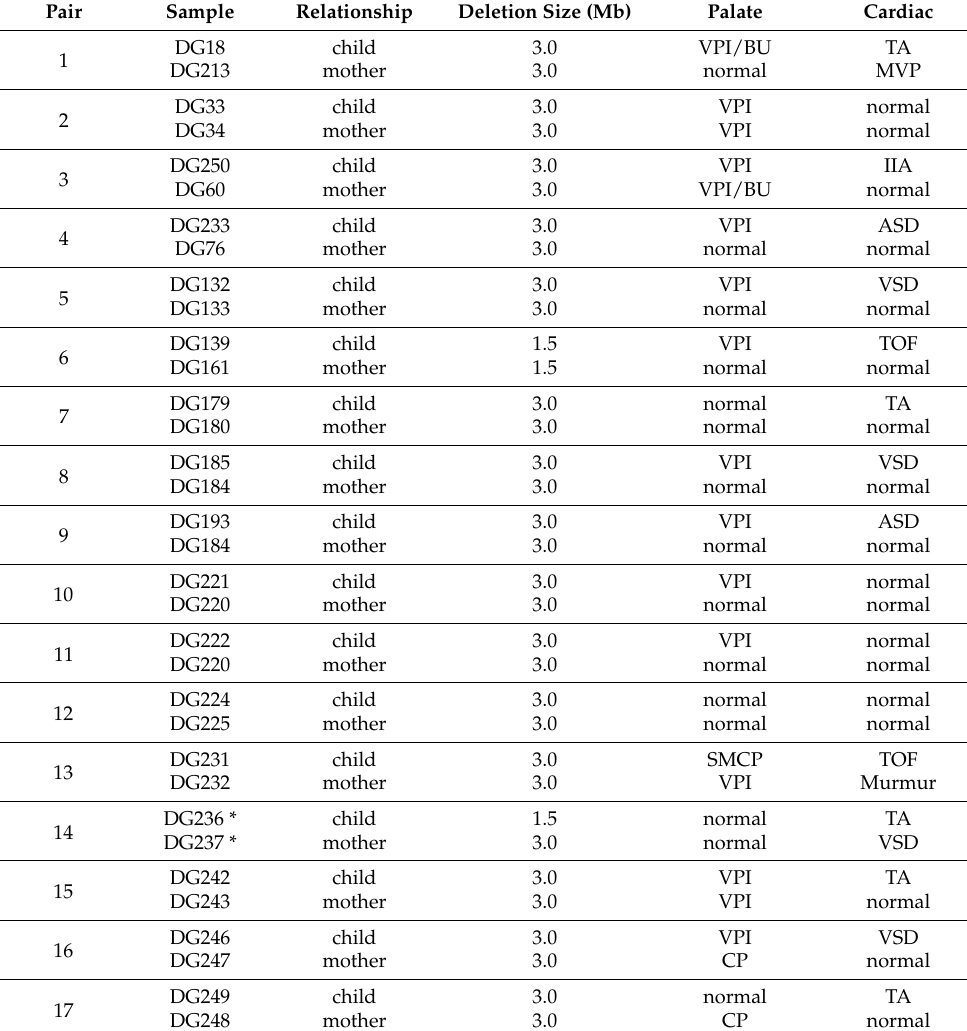
Table 1. Clinical phenotype of patients included in this